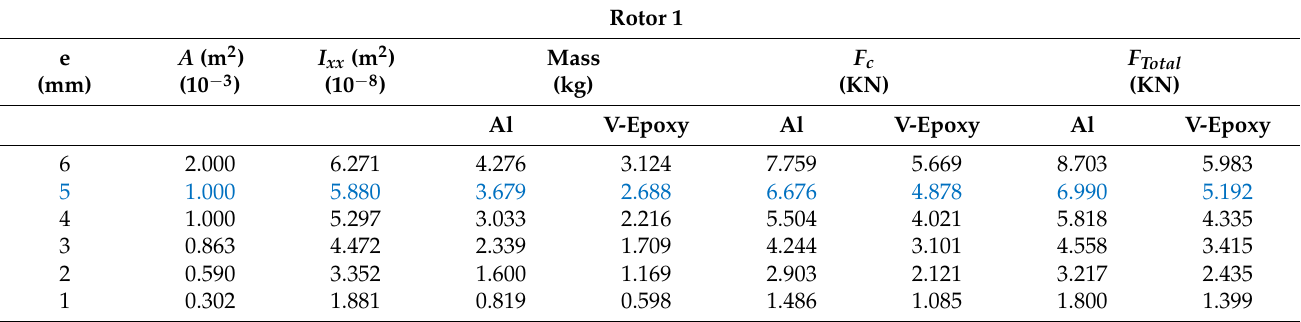
Table 6. Comparison of total forces acting on rotor blade 1 for aluminum and glass–epoxy materials as a function of different thicknesses.